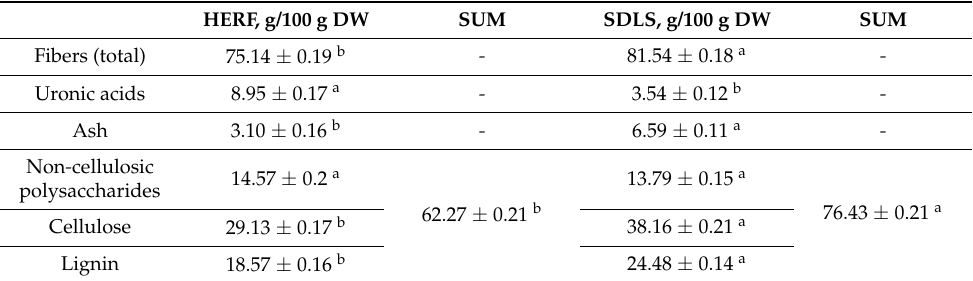
Table 1. Proximate composition of hexane extracted rose flowers (HERF) and steam distilled lavender straw